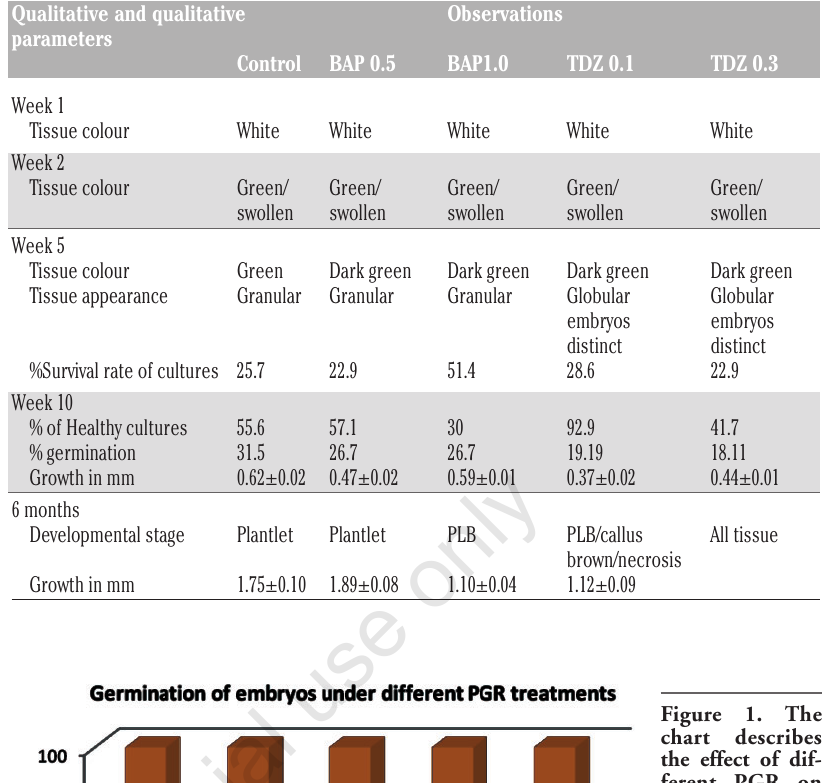
Figure 1. The chart describes the effect of dif- ferent PGR on development and germination of i m m a t u r e embryos during 3 months under culture (n=1021 (TDZ0.1), n= 1882 (TDZ0.3), n=930 (BAP0.5), n= 1139 ( B A P 1 . 0 ) , n = 1 0 8 2 (Control).